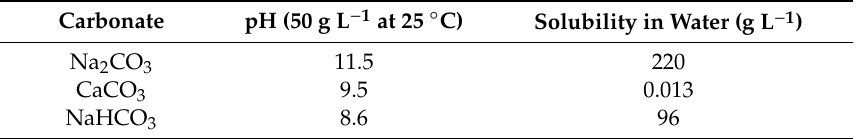
Table 1. Solubility and pH values of Na 2 CO 3 , CaCO 3 , and NaHCO 3 at 50 g L − 1 concentration at 25 ◦ C